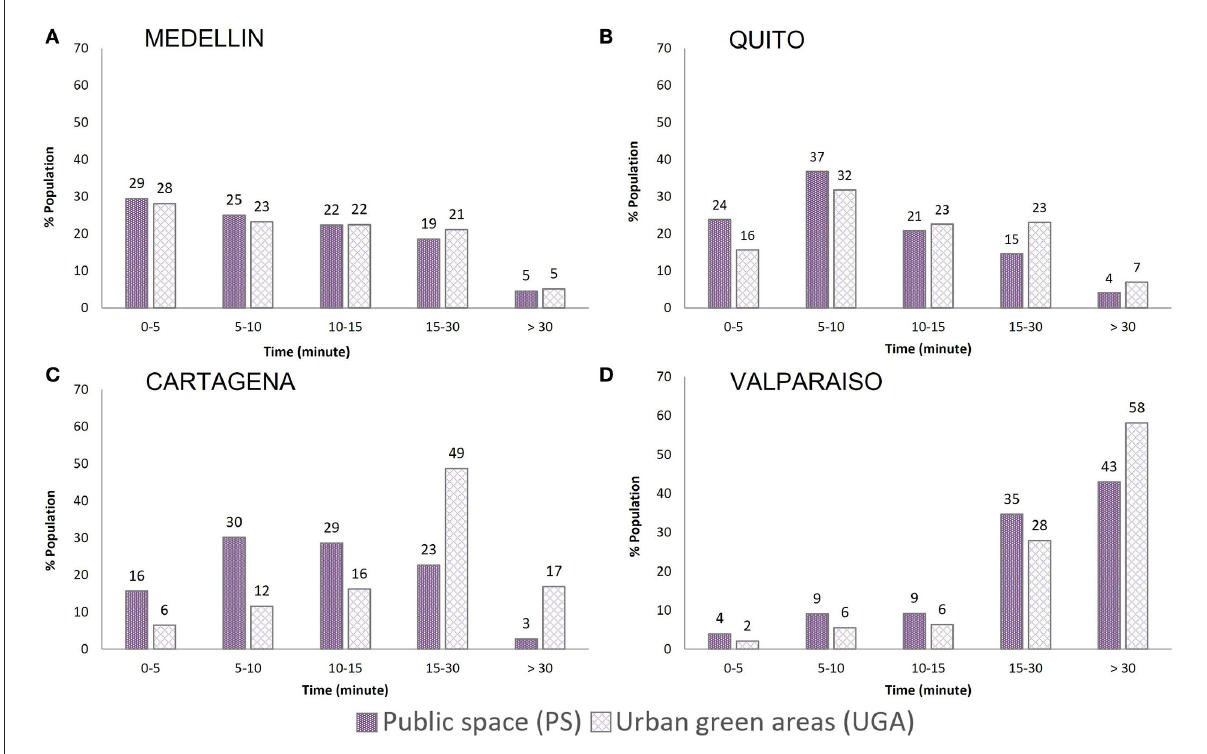
FIGURE8 Percentage of population with access to public spaces and UGA: Medellín (A) , Quito (B) , Cartagena (C) , and Valparaíso (D). Sources: Prepared by the